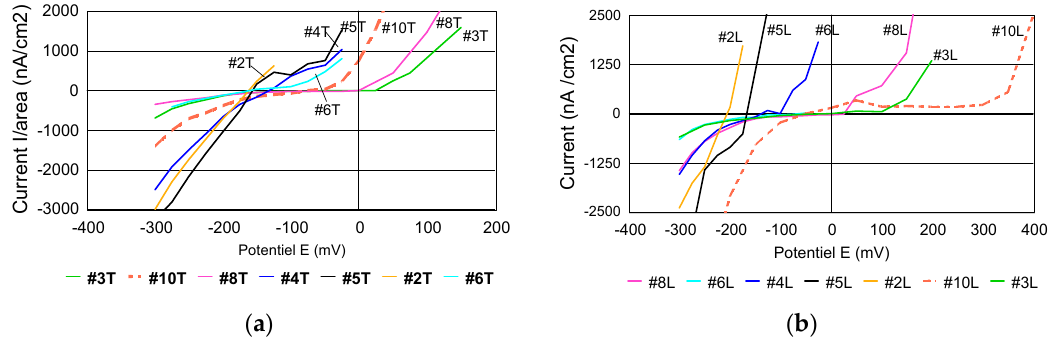
Figure 14. Polarization curves (current value recorded after 15 min vs. preselected potential; ( a ) transverse and ( b ) longitudinal surface.